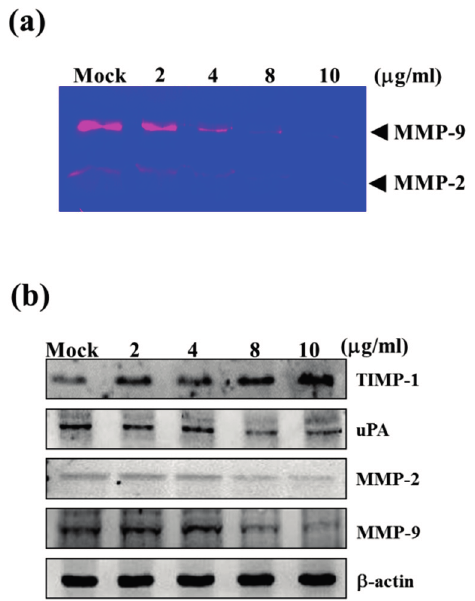
Figure 3. Effects of the MMP-2/-9 activities and protein levels in HA22T cells by sinulariolide. The HA22T cells were treated with different concentration of sinulariolide (0, 2, 4, 6, 8 μ g/mL) for 24 h, and conditioned media and cell lysates were collected respectively for gelatin zymography assay and western blotting. ( a ) The gelatin zymography assay showed MMP-2/-9 activities were inhibited by sinulariolide in HA22T cells; ( b ) The MMP-2/-9 related proteins were validated, including TIMP-1, uPA, MMP-2, and MMP-9. The protein levels of MMP-2/-9 and uPA were decreased, but TIMP-1 was increased in HA22T cells. β -Actin was used as the internal control. Mock: control, the DMSO-treated